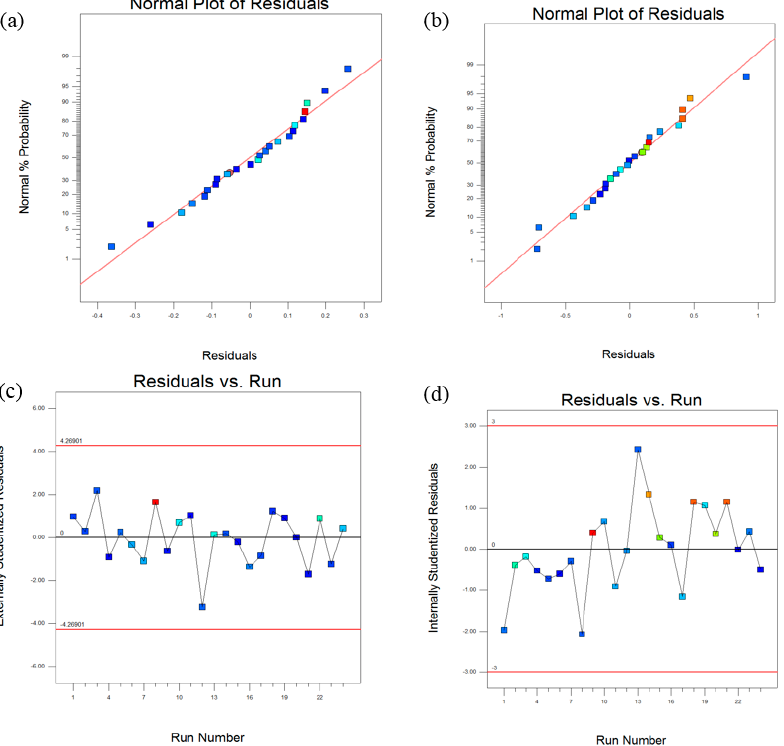
Figure 9. Normal plots of residuals: ( a ) HDR and ( b ) SR and Residuals versus Runs plots for: ( a ) HDR and ( b ) SR.